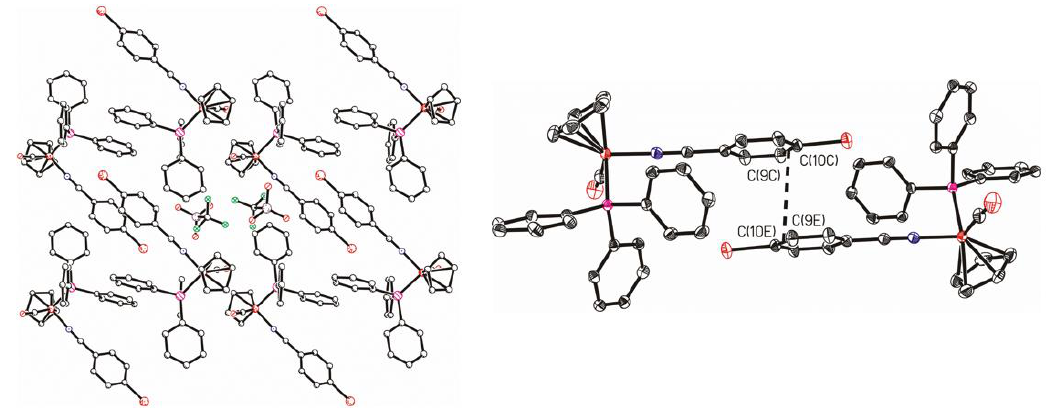
Figure 5. Crystal packing of the compound [Fe( η 5 -Cp)(CO)(PPh 3 )(p-NCPhBr)][CF 3 SO 3 ] 5 (left; drawing were done with SHELXTL program by balls and sticks). Short contacts between complexes are showed in dashed black lines (right; drawing was done with SHELXTL program by their 50% probability ellipsoids). Hydrogen atoms are omitted for clarity.